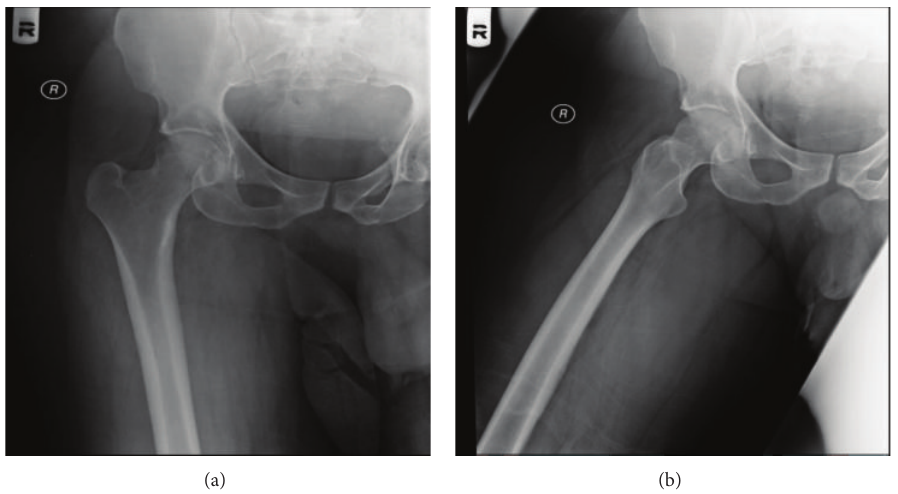
Figure 1: Right hip joint X-ray, (a) anteroposterior view and (b) abduction view.